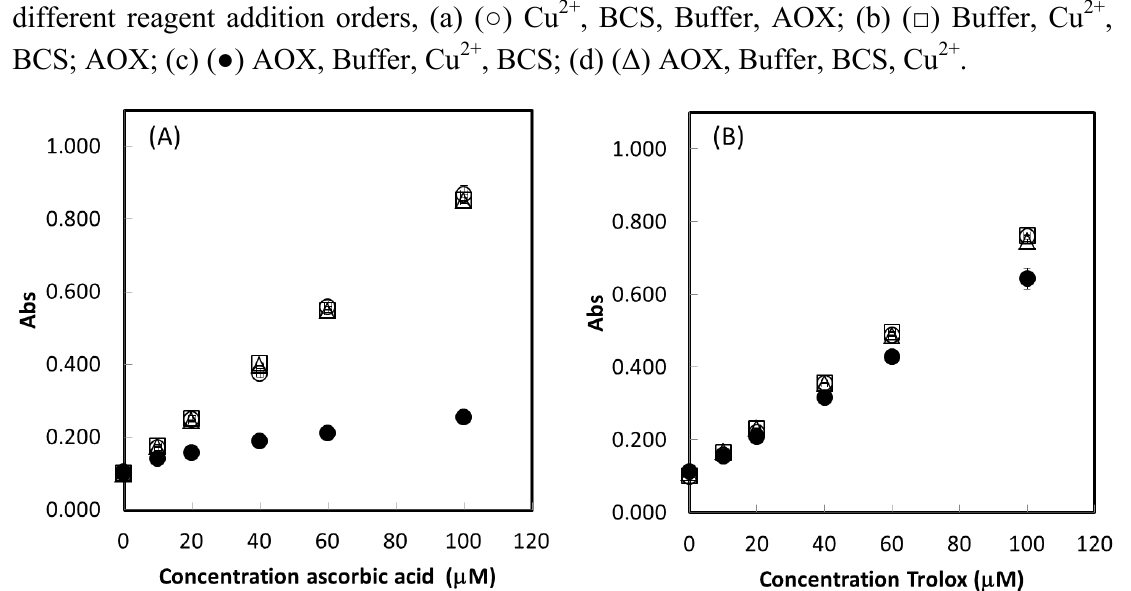
Figure 2. Response curves for ascorbic acid ( A ) and Trolox ( B ) antioxidants using different reagent addition orders, (a) (○) Cu 2+ , BCS, Buffer, AOX; (b) (□) Buffer, Cu 2+